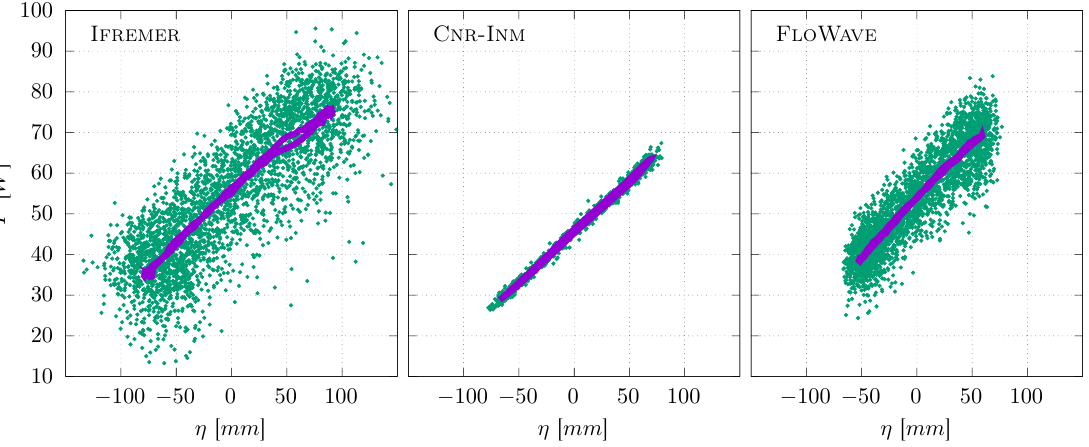
Figure 19. Power production of the turbine P versus the water level η measured by the wave probe 3 (cf. Figure 6), for the wave and current case 2 at TSR = 4. Green points stand for the raw data and violet curve is the wave phase average of the power versus the wave phase average of the surface elevation.